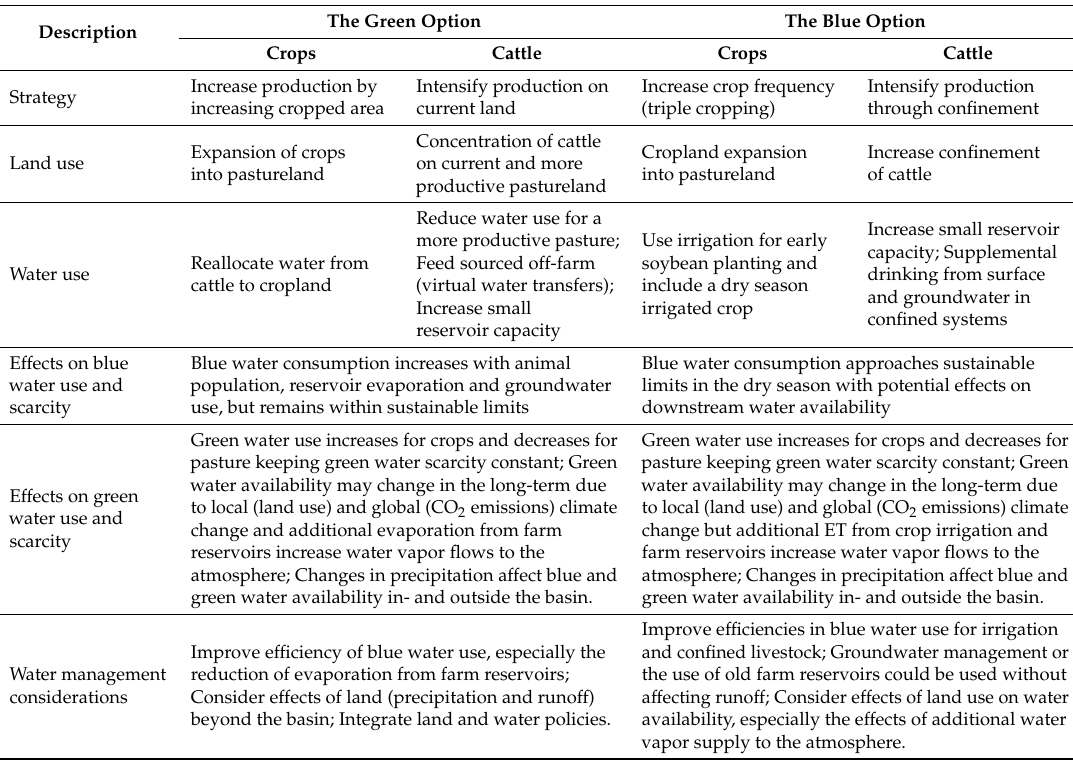
Table 2. Summary of effects and responses for two agricultural production options focused on production intensification in the Xingu Basin of Mato